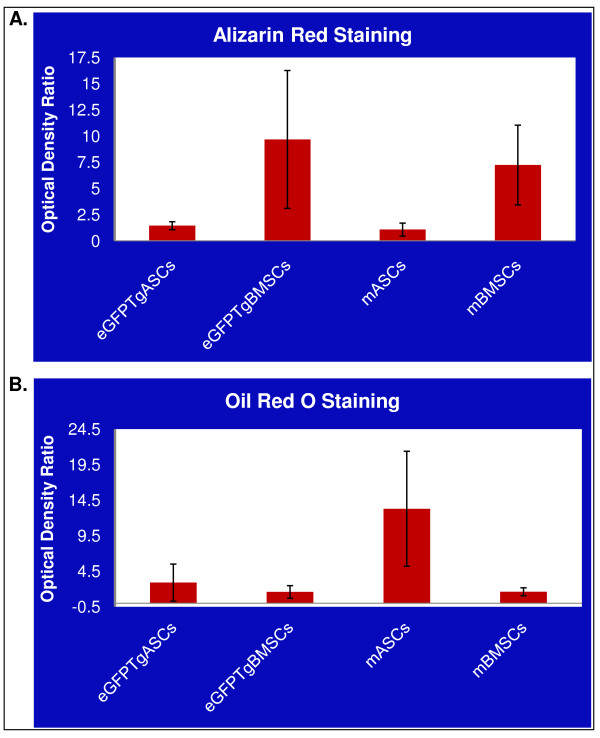
Quantitative differentiation of mMSCs and GFPTgMSCs along osteogenic and adipogenic lineages. A. Cells were incubated in CEM and then transferred to osteogenic media for 14 days. The cells were then stained with Alizarin Red and de-stained with 10% cetylpyridinium chloride. Optical density (OD) was measured at 560 nm and normalized to protein content. Graphs represent the ratio of normalized OD of differentiated cells and normalized OD of control cells. B. Cells were incubated in CEM and then transferred to adipogenic media for 14 days. The cells were then stained with Oil Red O and de-stained with isopropanol. OD was measured at 520 nm and normalized to protein content. Graphs represent the ratio of normalized OD of differentiated cells and normalized OD of control cells.